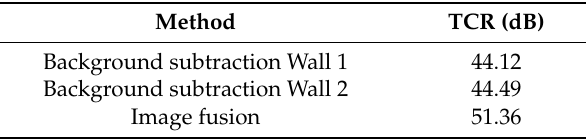
Table 3. Comparison of multiple target 2-wall case.